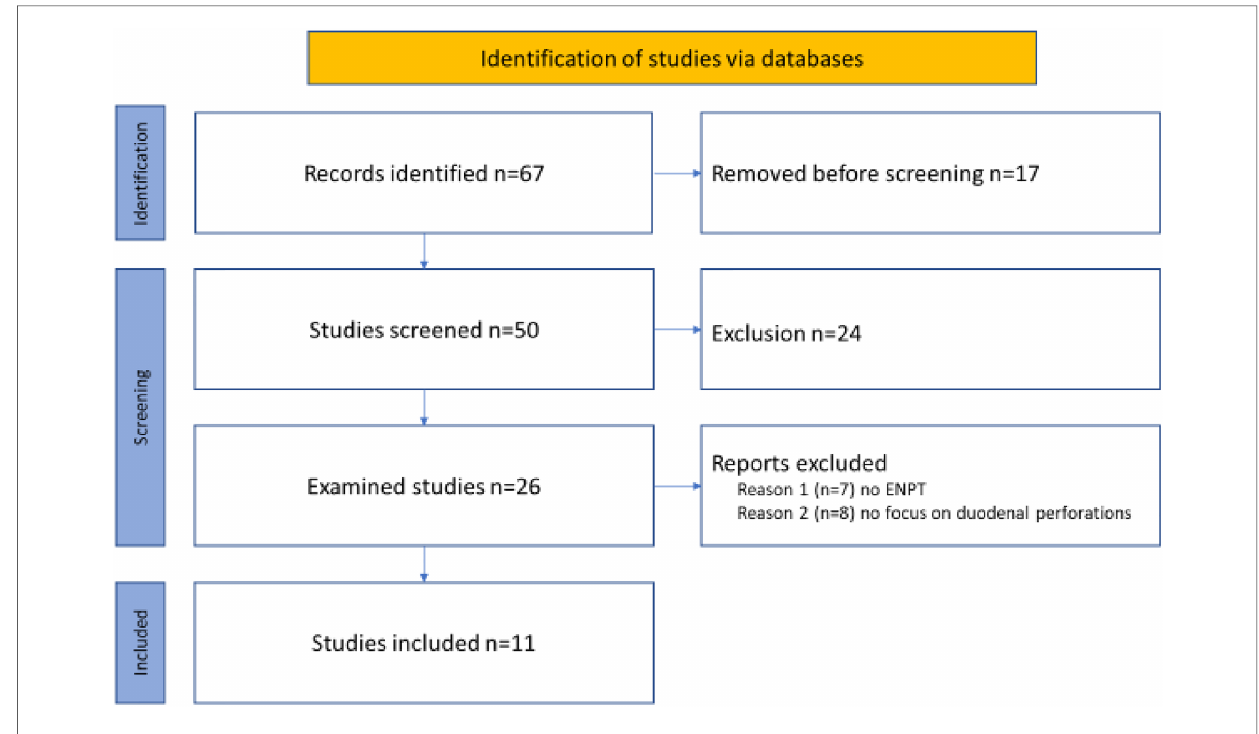
FIGURE 2 PRISMA 2020 fl ow diagram for the review process.